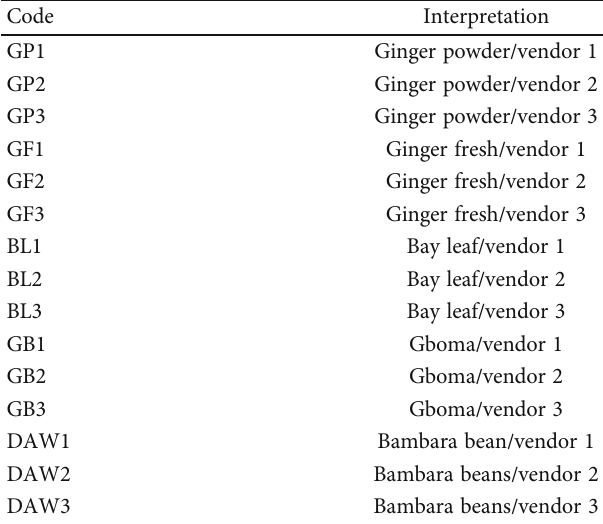
Table 1: Spices and herb samples and their corresponding